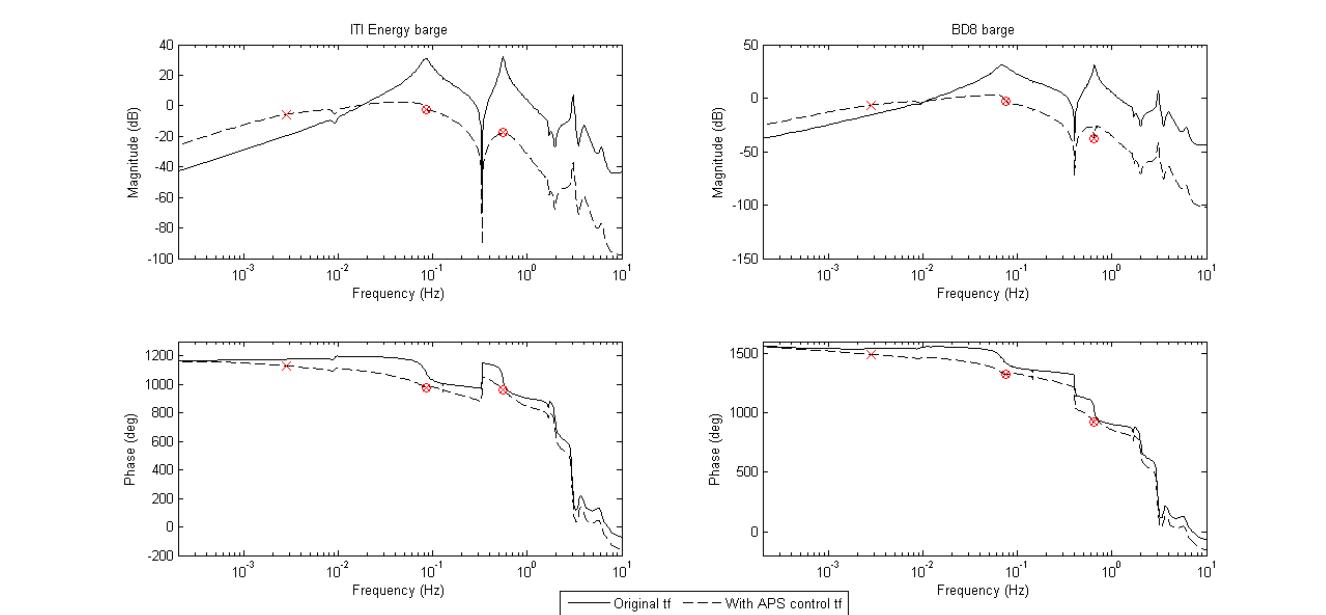
Figure 5. Open loop transfer functions from the blade-pitch to the nacelle nod